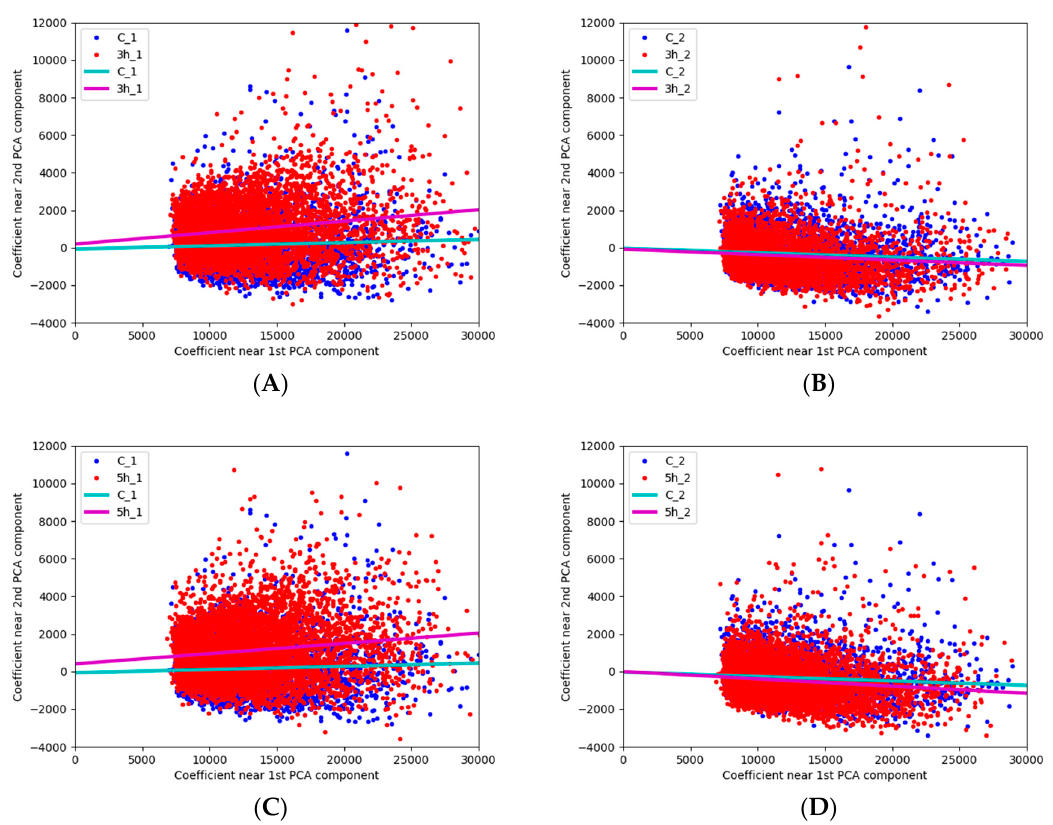
Figure 6. Dispersion charts with linear trends of PCA components of experimental variant groups: ( A )—three-hour ozone exposure in comparison to control (pollen stored for one month before the start of the experiment); ( B )—three-hour ozone exposure in comparison to control (pollen was stored for five months before the start of the experiment); ( C )—five-hour ozone exposure in comparison to control (pollen was stored for one month before the start of the experiment); ( D )—five-hour ozone exposure in comparison to control (pollen was stored for five months before the start of the experiment).